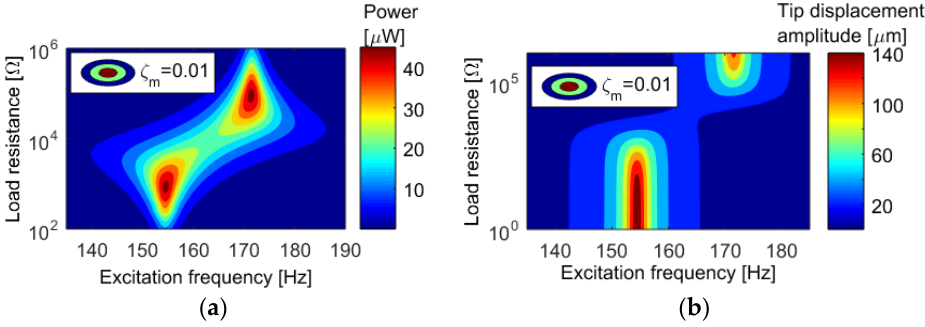
Figure 4. The impact of the applied load resistance and excitation frequency on ( a ) the output power ( b ) the tip displacement.